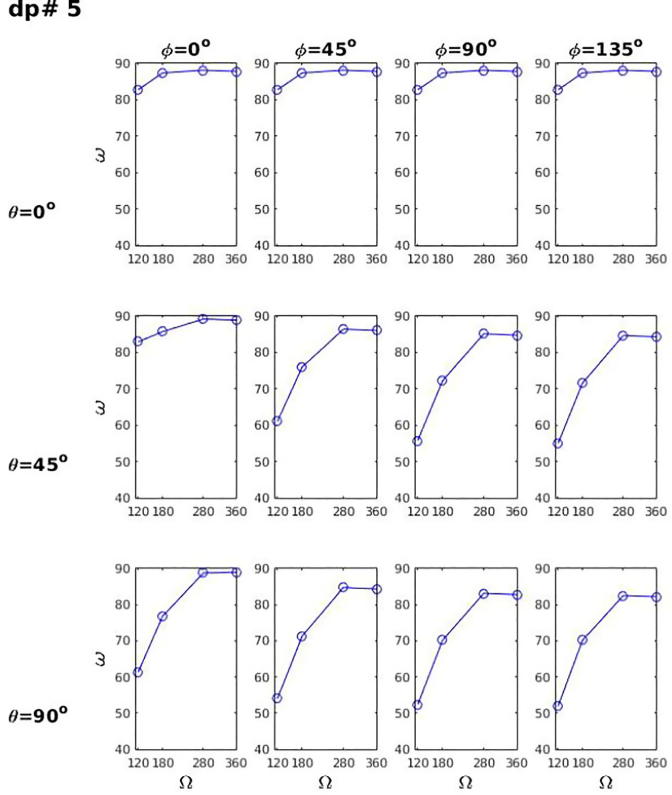
Subspace angle (ϖ) between the signal dipole (red sphere (see Fig. 5 inset)) and noise dipole 5 as a function of coverage angle of the sensor array (Ω) for different angular separations θ and ϕ. For this deep and lateral noise dipole, ϖ depends on Ω, θ and ϕ.